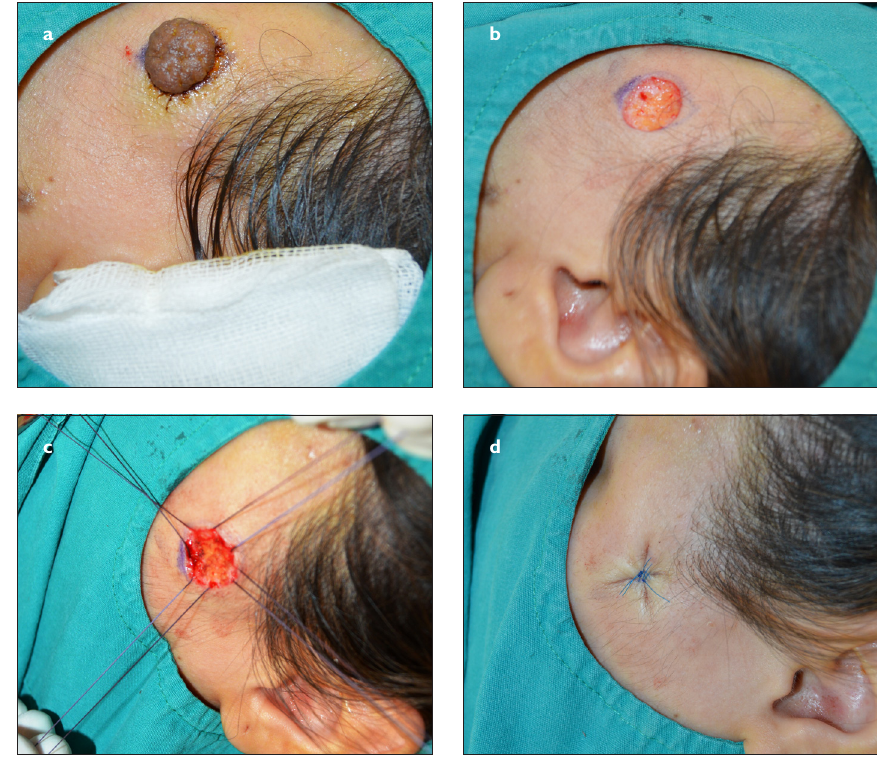
Figure 1. a-d. (a) The tumor is marked as circular, (b) Round defect after resection, (c) Application of four quadrant embedded purse string suture, (d) Final intraoperative appearance after completion of skin